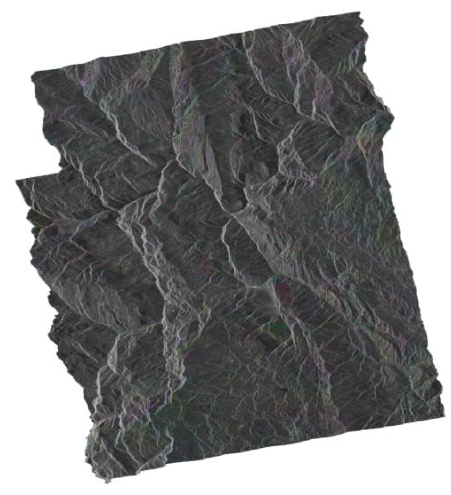
Figure 4 Differential interference pattern